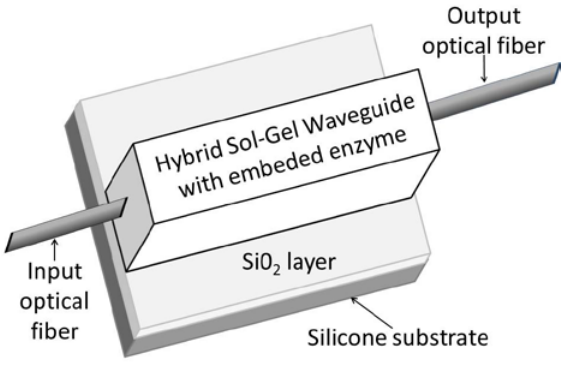
Figure 10. Bio-doped polymeric strip waveguide (Adapted from [94] with permission from the European Society for Photobiology, the European Photochemistry Association, and The Royal Society of